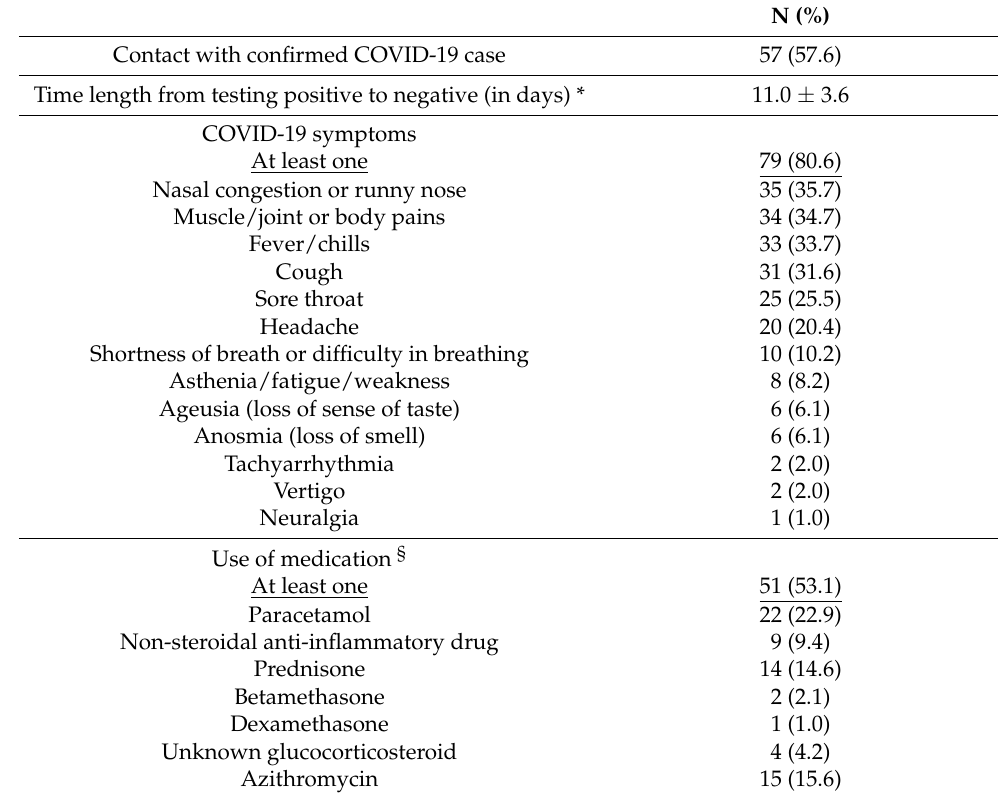
Table 3. Characteristics of the breakthrough infection in the study population (n = 98).